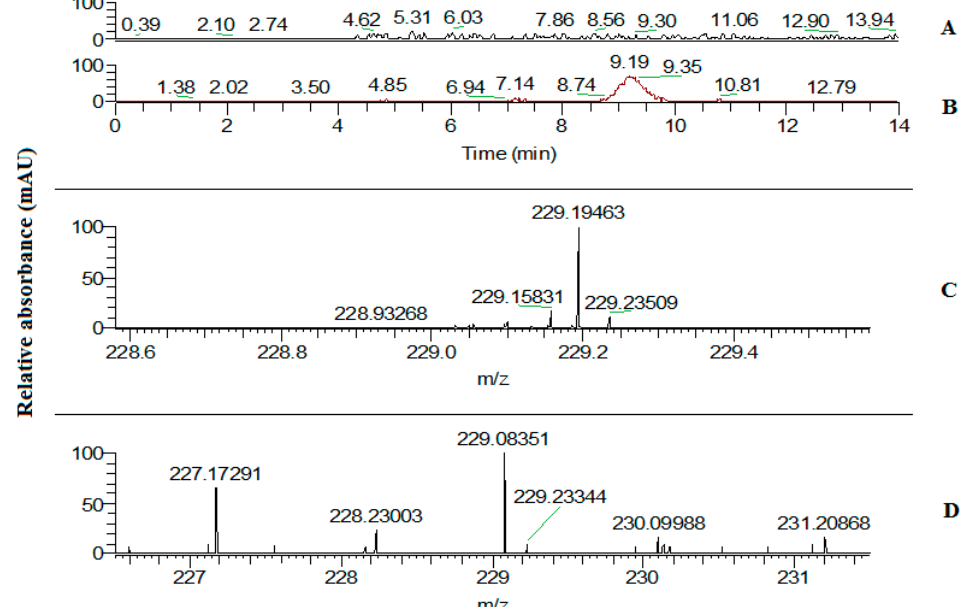
Figure 6. Mass chromatograms ( A , B ) and mass spectra ( C , D ) for control and experimental samples (extracts from leaves of control plants and transgenic L10 plants expressing the VlvSTS gene). The chromatograms show that there were no ions with the mass m / z 229.083 in the control sample ( A ), whereas the chromatographic peak of resveratrol was observed in the experimental sample ( B ). The lower part of the figure shows mass spectrum of ions formed from products eluted out of the column at 9.19 min. The control sample had no peak corresponding to the mass of 229.083 ( C ), while that was the major peak presented by the experimental sample ( D ).